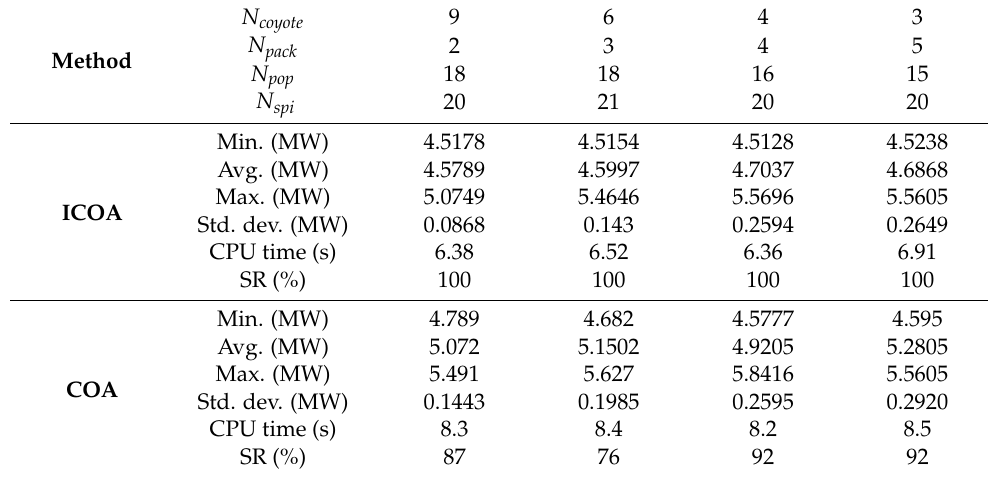
Table 2. Results found by the proposed ICOA approach for TPL objective of the IEEE 30-bus system. N coyote Method